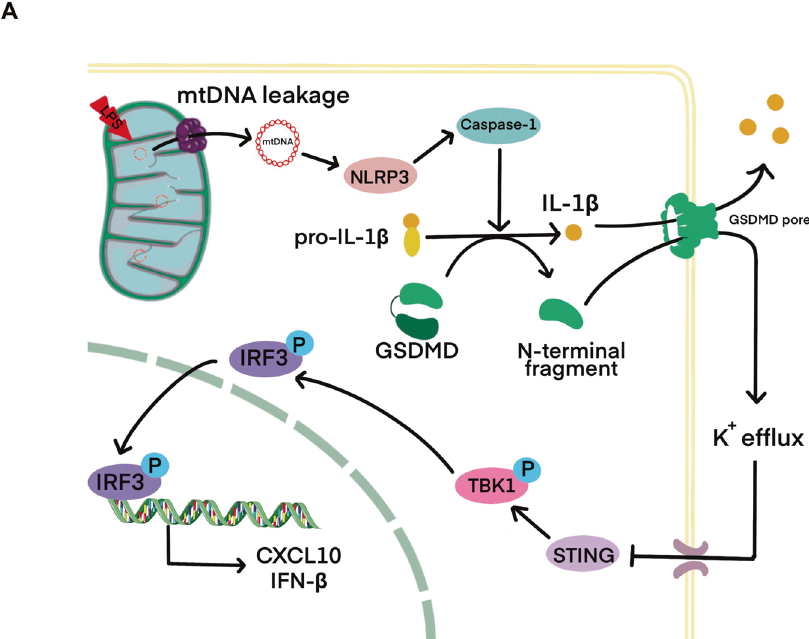
Fig. 6 The mechanism diagram for cytosolic mitochondrial DNA regulates odontoblast in fl ammation. A Cytosolic mitochondrial DNA regulates odontoblast in fl ammation via pyroptosis. STING pathway compensatorily regulates the in fl ammatory